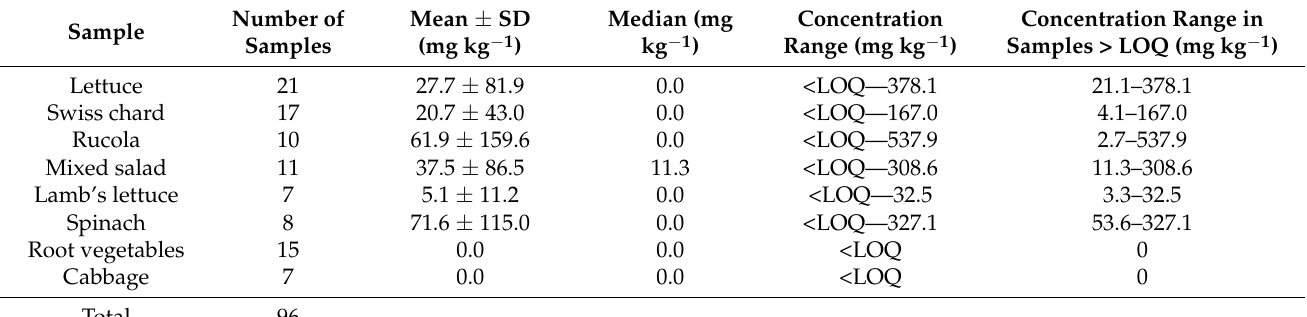
Table 2. Distribution and levels of nitrite (mg kg − 1 ) in the different types of vegetables in this